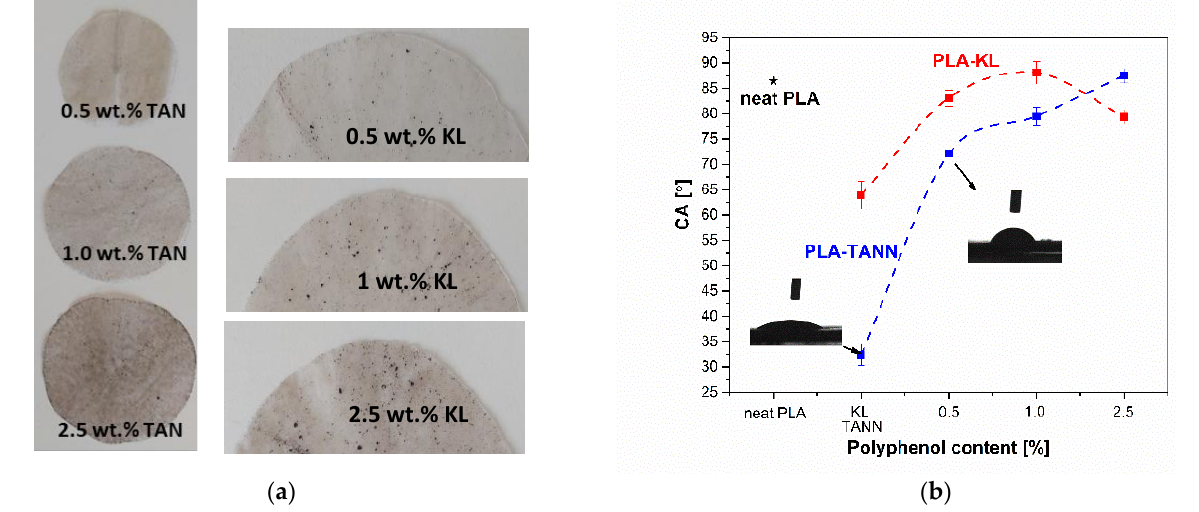
Figure 2. Images samples of ( a ) PLA-TANN and PLA-KL composite films using different KL and TANN concentrations. The wettability of ( b ) neat PLA, KL, TANN, PLA-KL, and PLA-TANN composites as a function of wt % of KL and TANN loading. Star marker represents neat PLA material.